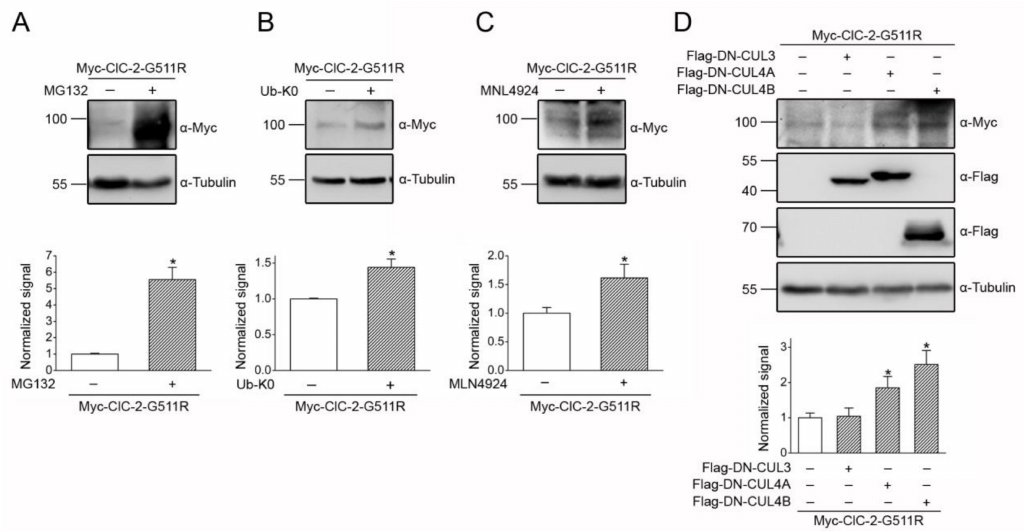
Figure 11. CUL4 E3 ligase contributes to leukodystrophy-associated defective ClC-2 proteostasis. ( A ) ( Upper panel ) Representative immunoblot showing the e ff ect of the 24-h treatment of 10 µ M MG132 on the Myc-ClC-2 G511R mutant in HEK293T cells. ( Lower panel ) Quantification of the relative ClC-2 G511R protein levels (*, t test: p < 0.05; n = 6). ( B ) ( Upper panel ) Representative immunoblot showing the e ff ect of the 24-h treatment of HA-UB-K0 co-expression on the Myc-ClC-2 G511R mutant. ( Lower panel ) Quantification of relative ClC-2 G511R protein levels (*, t test: p < 0.05; n = 3). ( C ) ( Upper panel ) Representative immunoblot showing the e ff ect of the 24-h treatment of 10 µ M MLN4924 on the Myc-ClC-2 G511R mutant. ( Lower panel ) Quantification of the relative ClC-2 G511R protein levels (*, t test: p < 0.05; n = 4). ( D ) ( Upper panel ) Representative immunoblot showing the e ff ect of Flag-DN-CUL3 / CUL4A / CUL4B co-expression on the Myc-ClC-2 G511R mutant. ( Lower panel ) Quantification of the relative ClC-2 G511R protein levels (*, t test: p < 0.05; n =